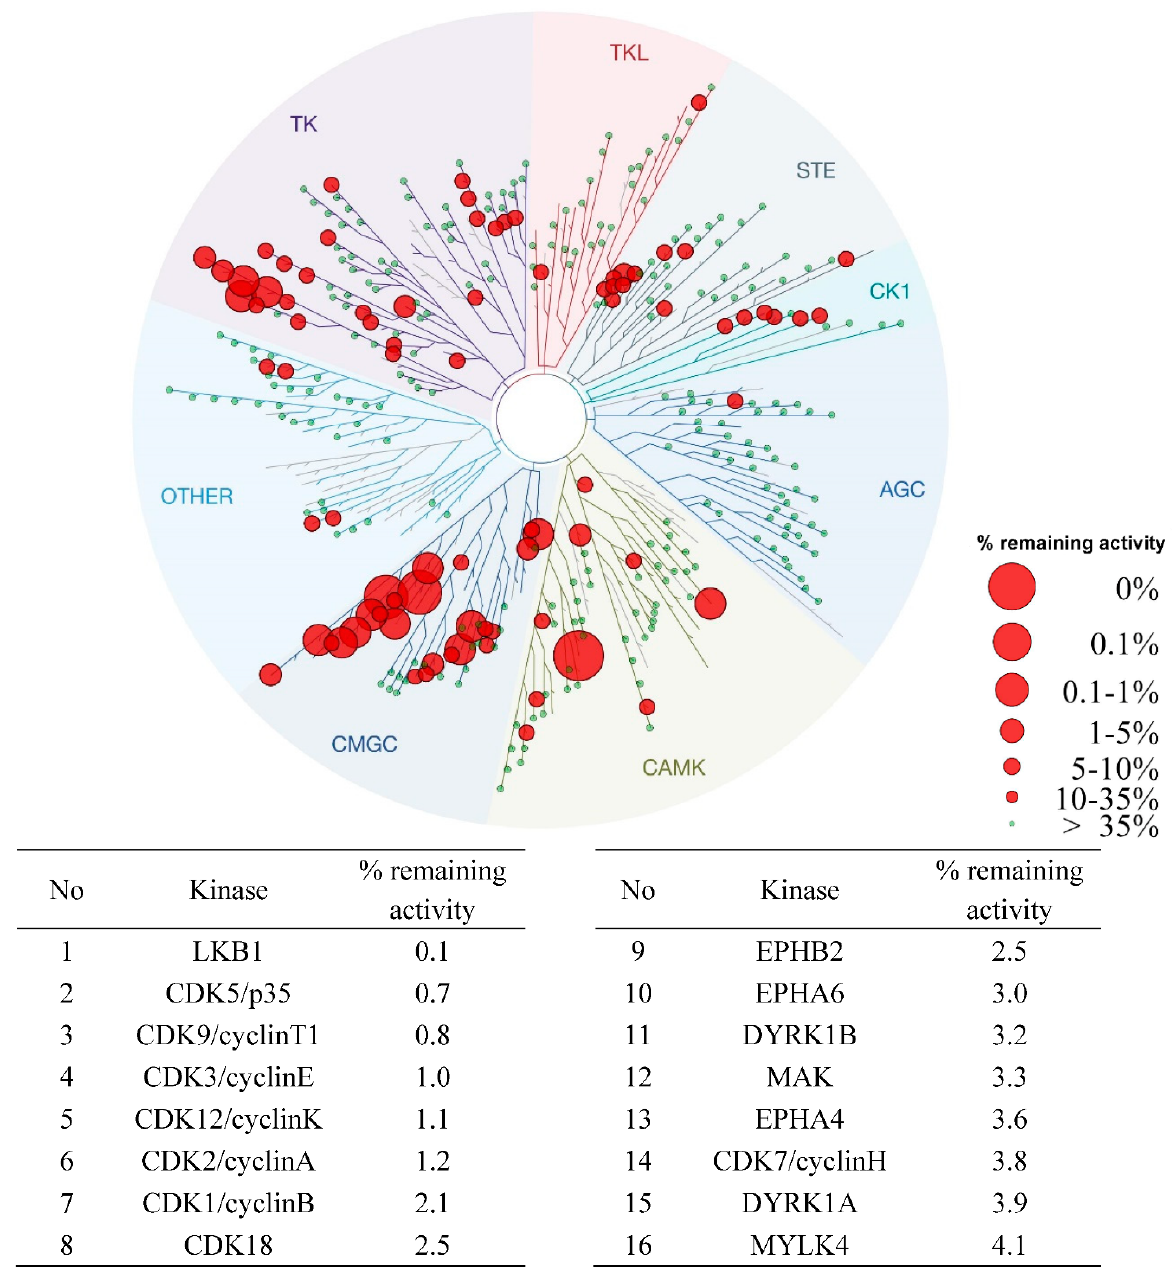
Figure 6. Kinome–wide inhibition profiling of 30d at 10 µ M against a panel of 359 human wild-type kinases. ( Top ) percent remaining activity of each kinase illustrated using a web–based TREE spot TM visualization tool (https://www.discoverx.com/services/drug--discovery--development--services/ treespot--data--analysis, accessed on 1 March 2022). ( Bottom ) the list of top-ranking kinases showing >95% inhibition by 10 µ M of 30d